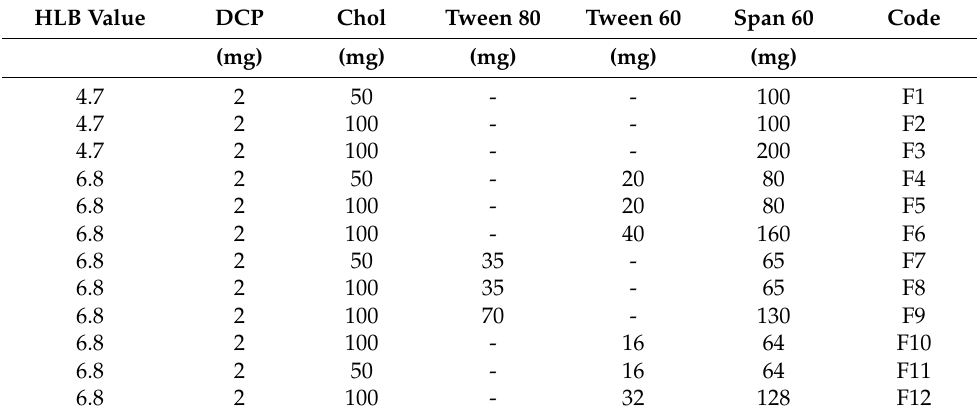
Table 1. The composition of ALS-loaded niosomes